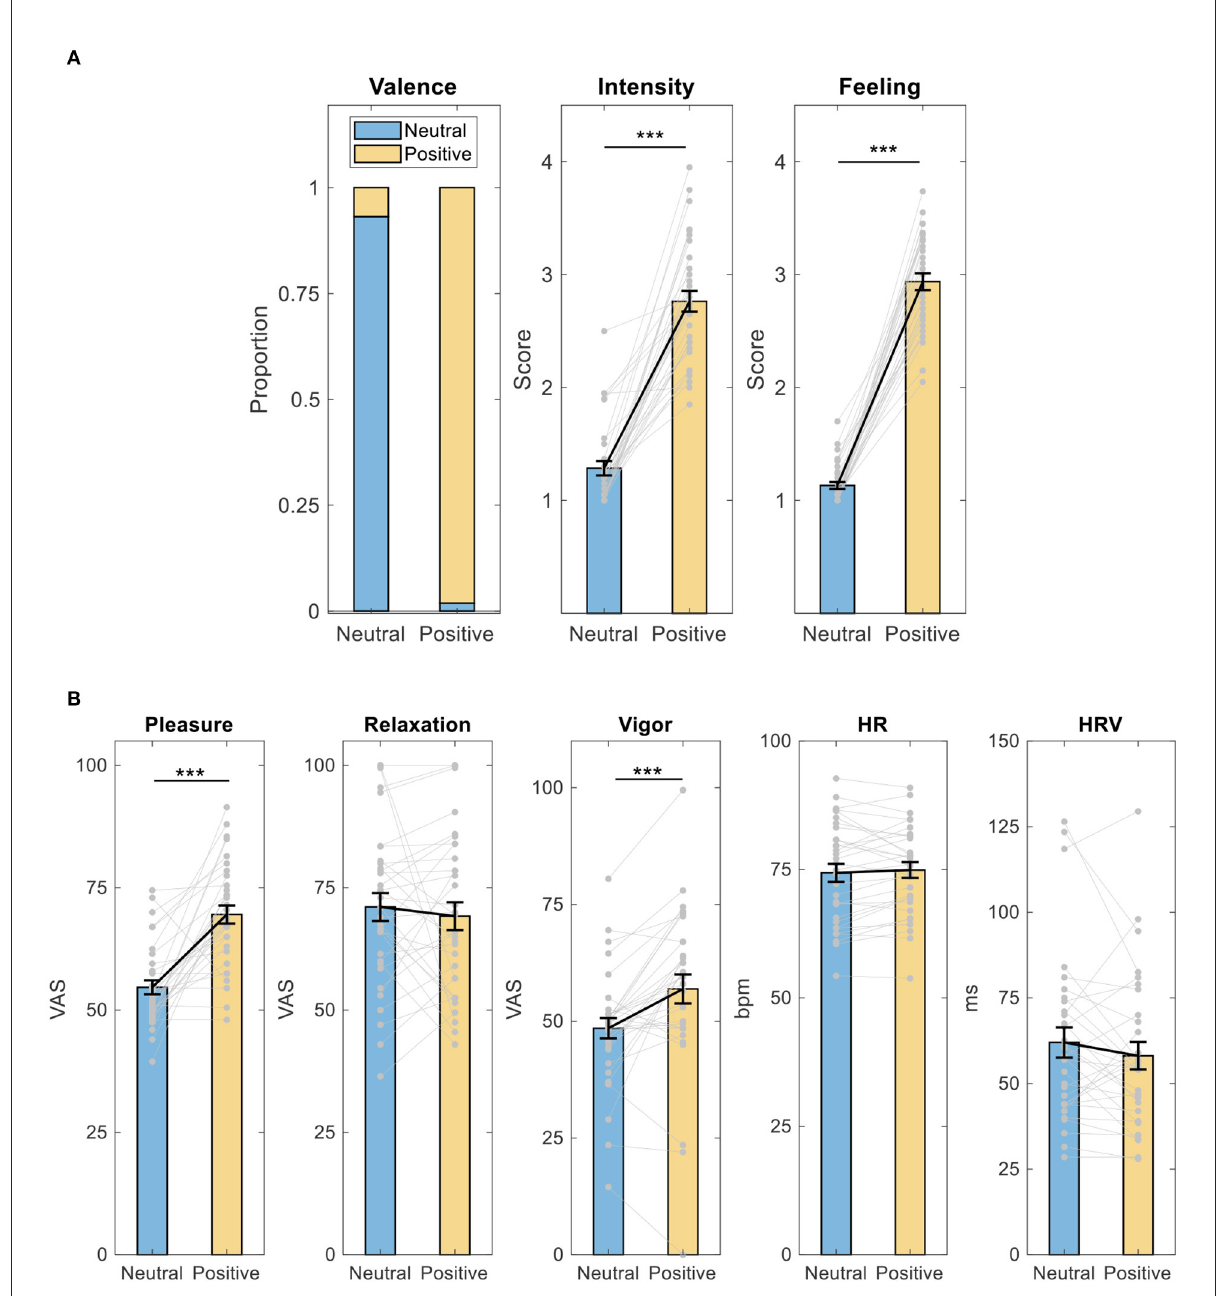
FIGURE2 Intervention effect on memory and feeling ratings, mood, HR, and HRV. (A) Memory and feeling ratings; (B) mood, HR, and HRV. *** p < 0.001, paired t -test. HR, heart rate. HRV, heart rate variability; VAS, visual analog scale; bpm, beat per minutes; ms, milliseconds. Data shown as mean ±